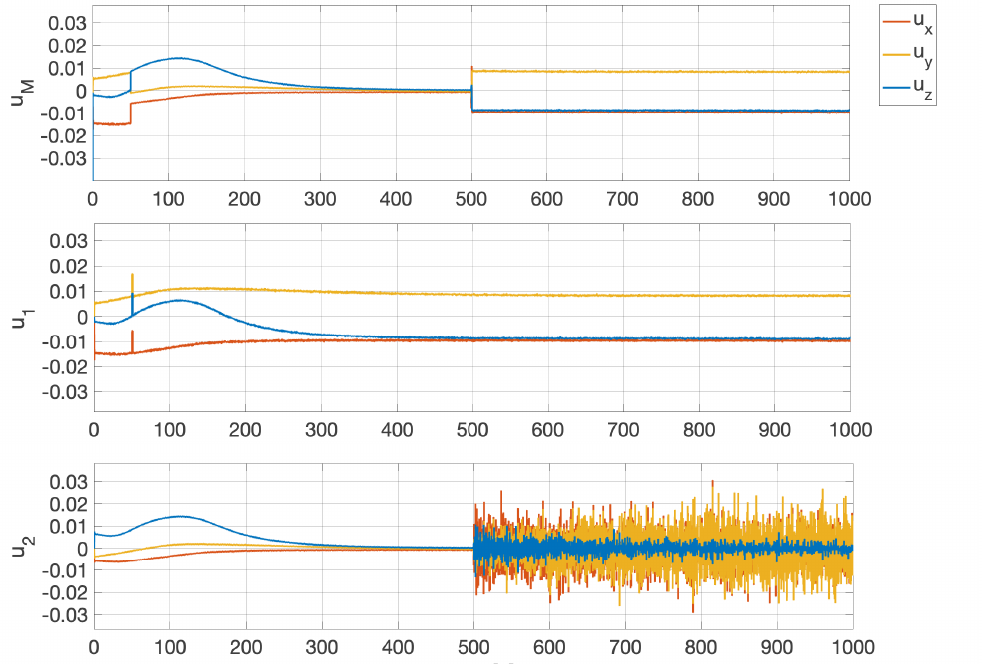
Figure 4. Redundant component management